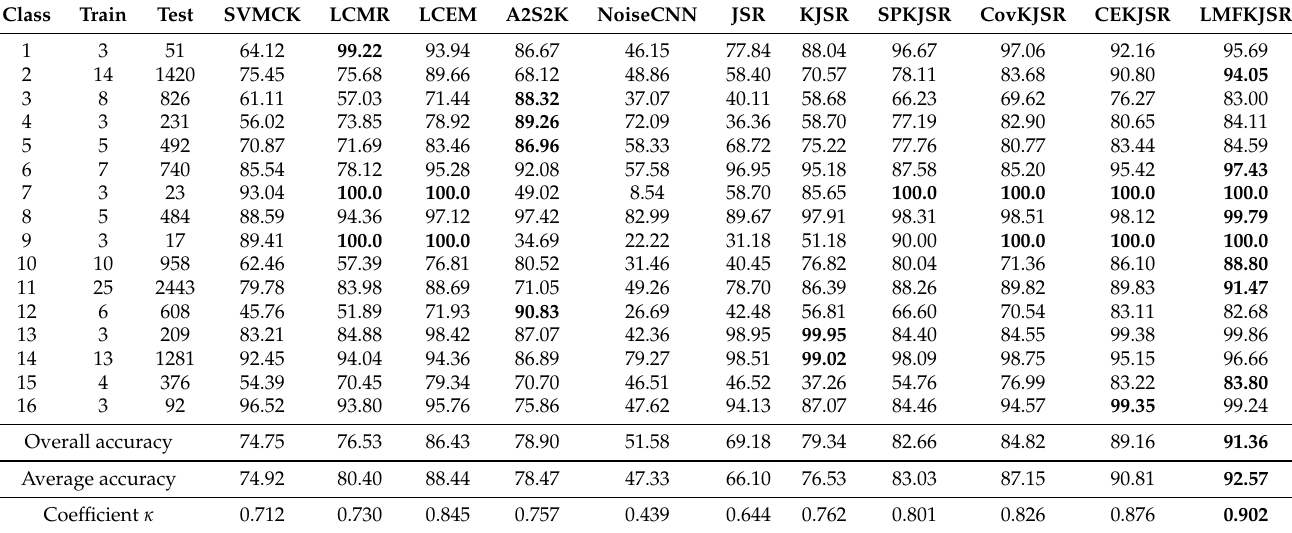
Table 1. Classification results on the IP data set with 1% labeled training samples (115 training samples). The bold values indicate the highest accuracy among all